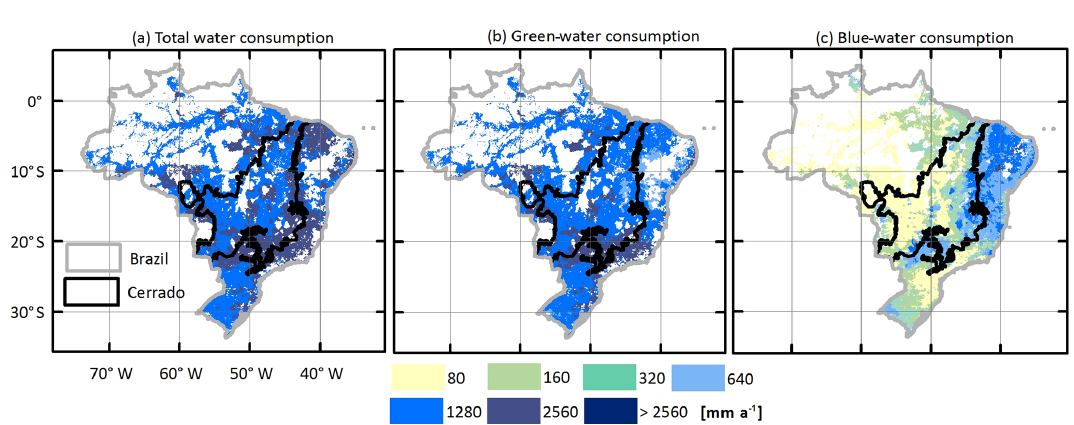
Figure 1. Spatial distribution of the water consumption in crop production in Brazil for the crops considered in this study: (a) total, (b) green- and (c) blue-water consumption. The black line delimits the Cerrado